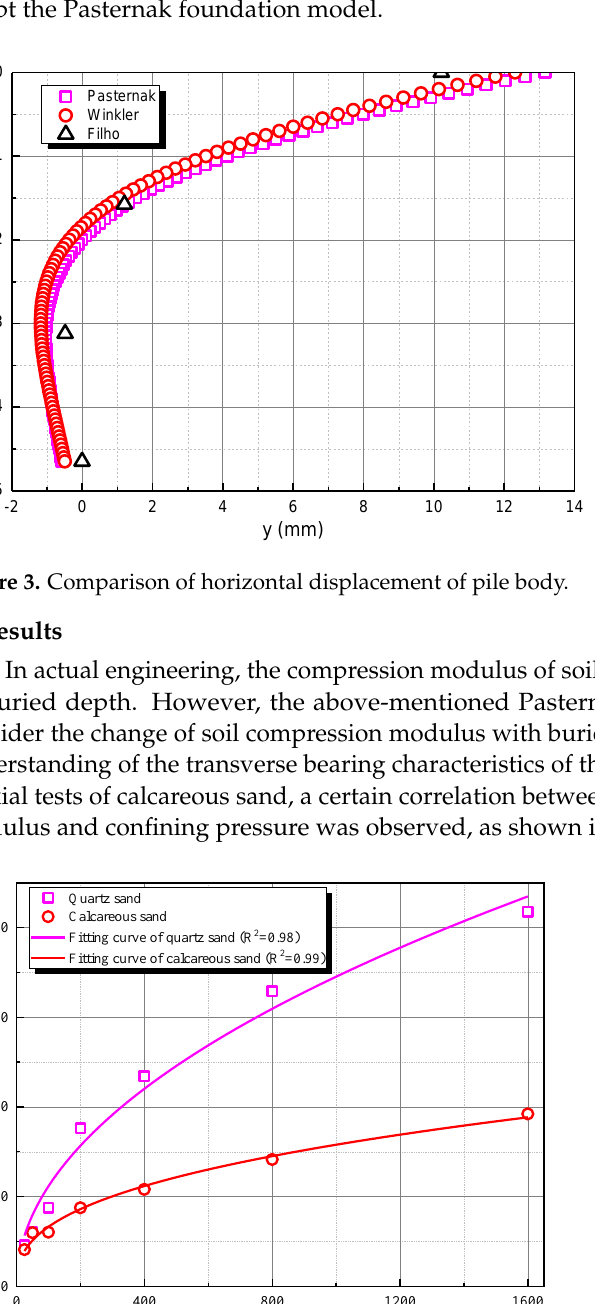
y (mm) Figure 5. Horizontal displacement of pile body.